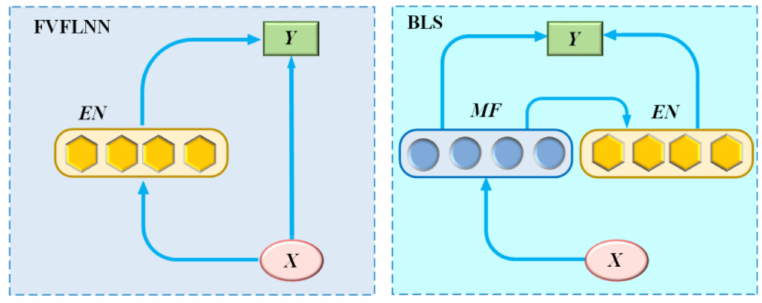
Figure 1. Structure of RVFLNN and BLS.